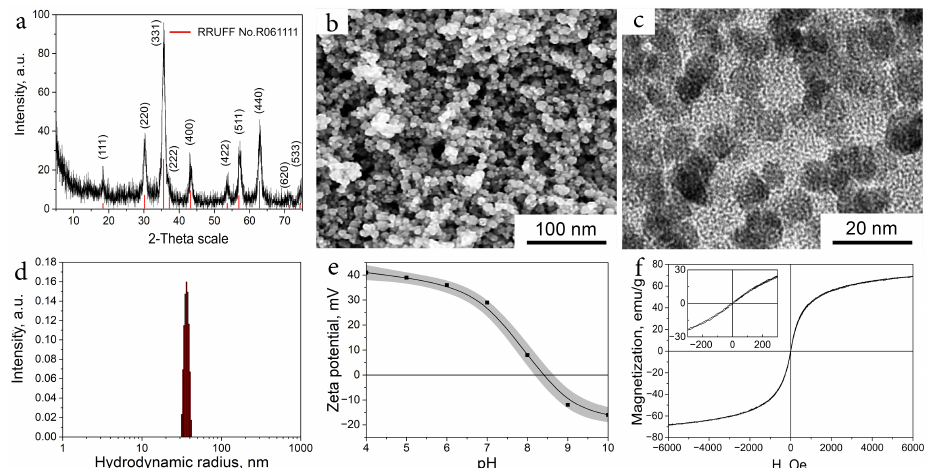
Figure 1. Characterization of magnetic cores. XRD pattern of Ferria ( a ); SEM image ( b ); TEM image ( c ); DLS characterization of Ferria ( d ); zeta potential as a function of pH ( e ); magnetization curve of the material ( f